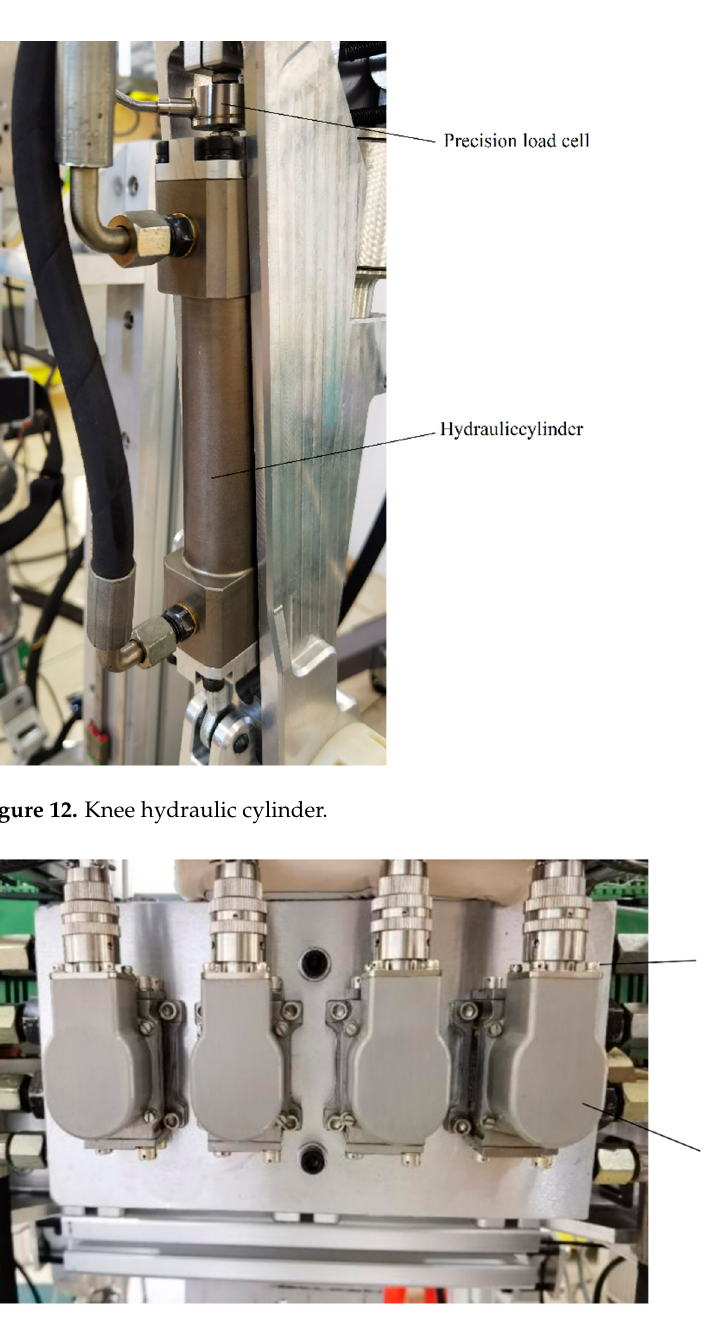
Figure 13. Servo valve block